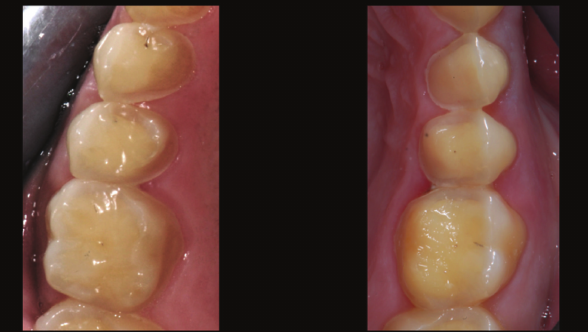
Figure 1: Case 1 (Monolithic Lithium Disilicate Onlays). Maxillary posterior teeth in a 25-year-old female patient affected by severe food behavior disorder (bulimia). One year before the dental treatment, she was considered healed by a psychotherapist and declared recovered. The teeth were not prepared; only minimal smoothing of some sharp edges was performed.